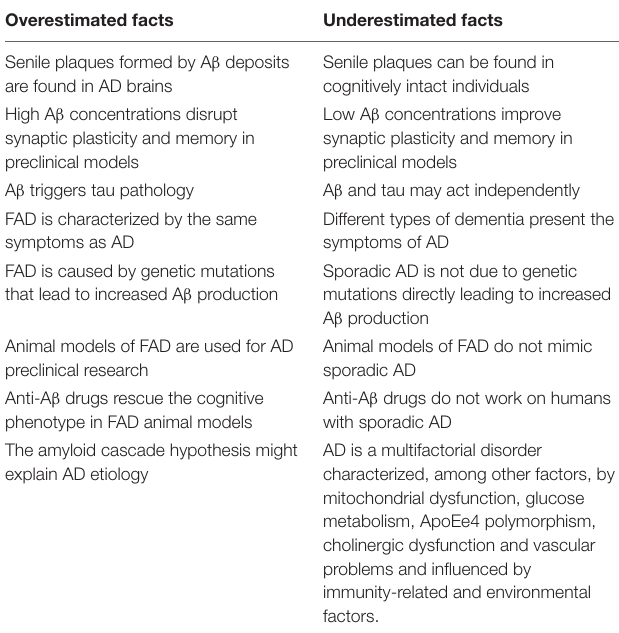
TABLE 2 | Amyloid-beta hypothesis